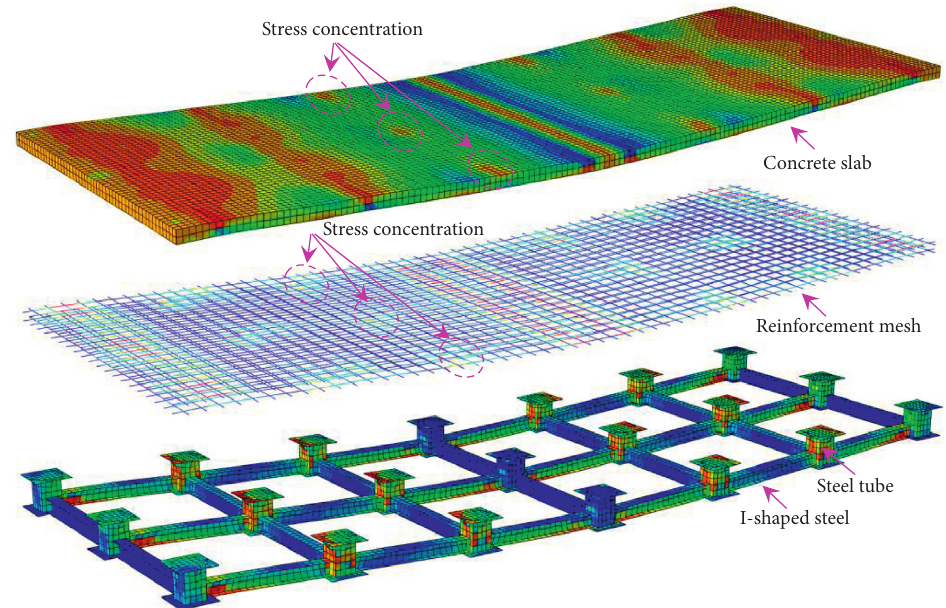
Figure 12: Stress states under vertical deflection of − 10.8